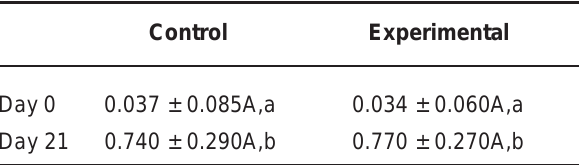
TABLE 2- Bleeding index (GBI) means and standard deviation on day 0 and day 21 for the control and experimental groups